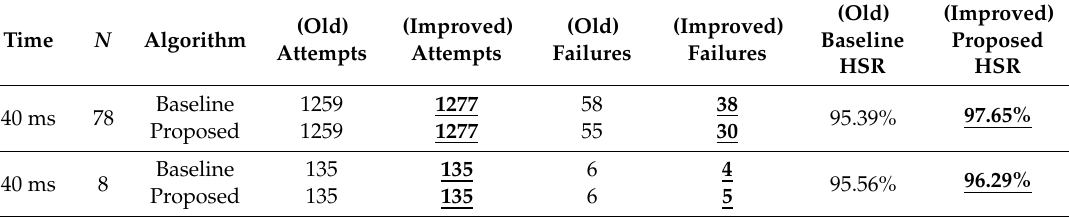
Table 12. Improvements in HSR with the improved algorithms.